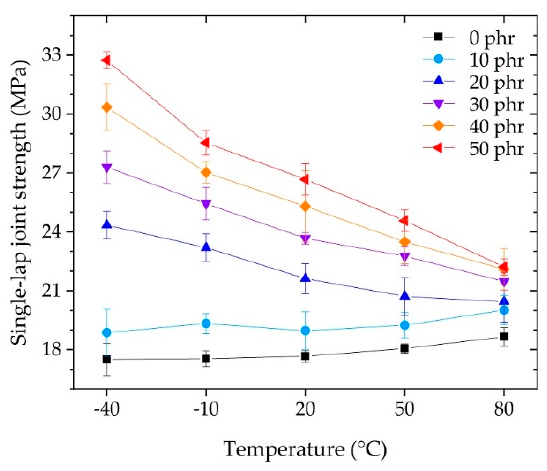
Figure 9. Strength of single-lap joint (SLJ) tests as a function of operating temperature.